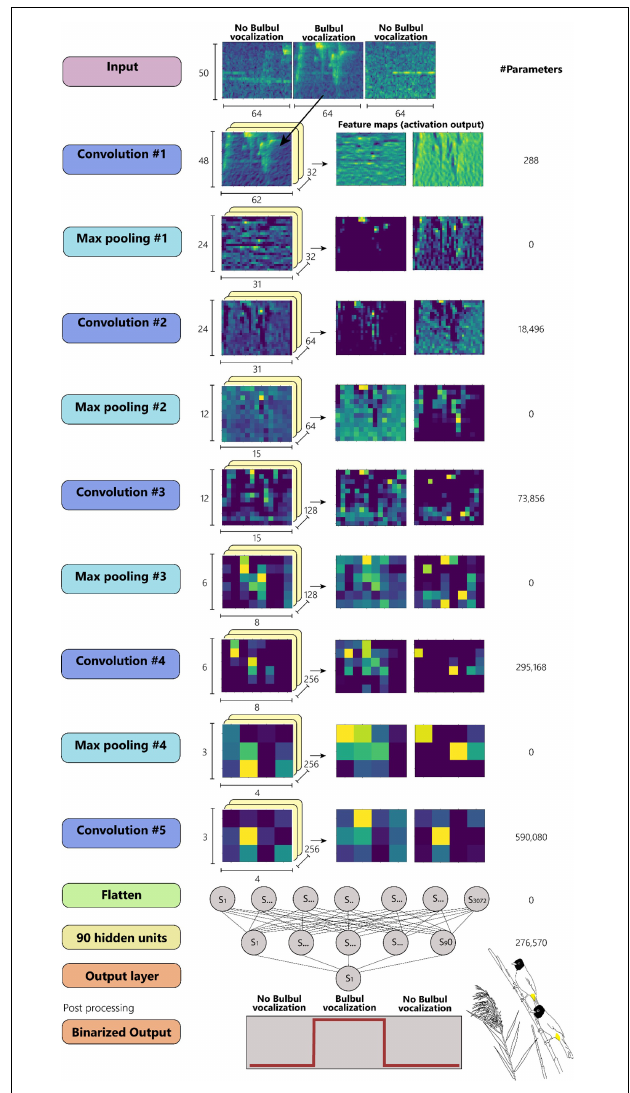
FIGURE 7 | A CNN model configuration with 5 convolutional layers. (Artwork by Aya